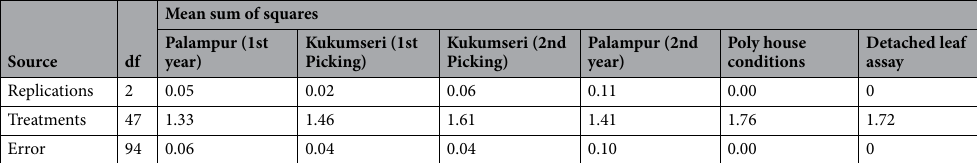
Table 4. Analysis of variance for powdery mildew disease incidence over